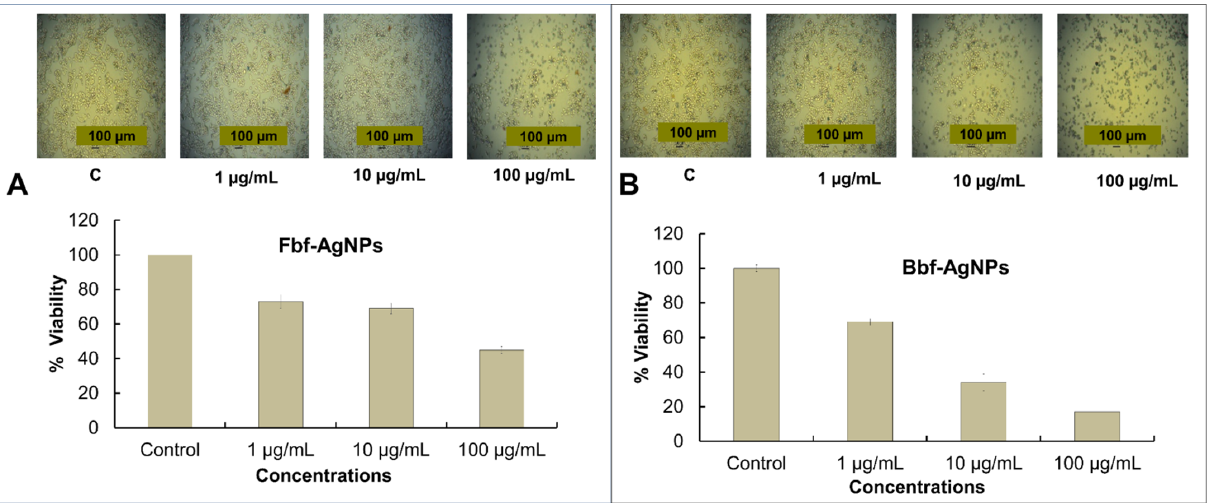
Figure 7. Cell viability percentage and the morphology of the biosynthesized Fbf-AgNPs and Bbf- AgNPs at different concentrations. Inset: Images ( A , B ) of the cell viability at different treated con- centrations.